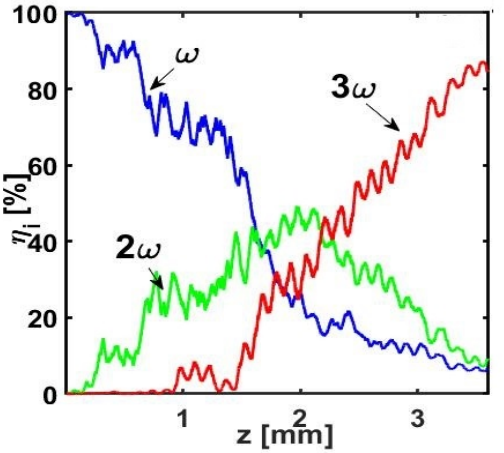
Figure 4. Results of the numerical experiments after 1000 iterations with reference to an aperiodically poled (z-cut) Lithium Niobate crystal with a total length of 4 mm. Normalized intensities η i ( i = 1, 2, 3) at the three frequencies along the propagation distance z for different domain sizes in each segment.